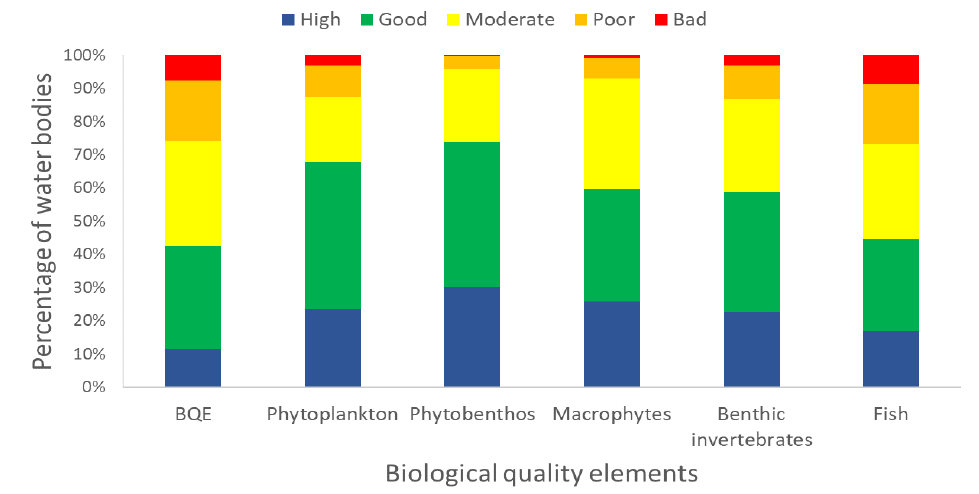
Figure 2. Percentage of water bodies belonging to different quality classes following biological quality assessment in European rivers (https://www.eea.europa.eu/themes/water/european-waters/water-quality-and-water-assessment/water-assessments/quality-elements-of-water-bodies, last accessed on 29 January 2021) based on the one-out/all-out approach (BQEs) and the most common BQEs. Colors show the different quality classes.